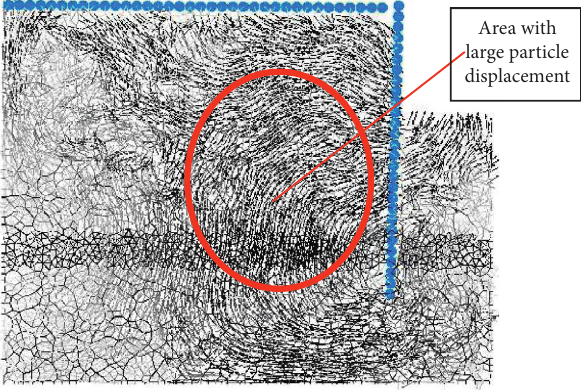
Figure 4: Illustration of particle